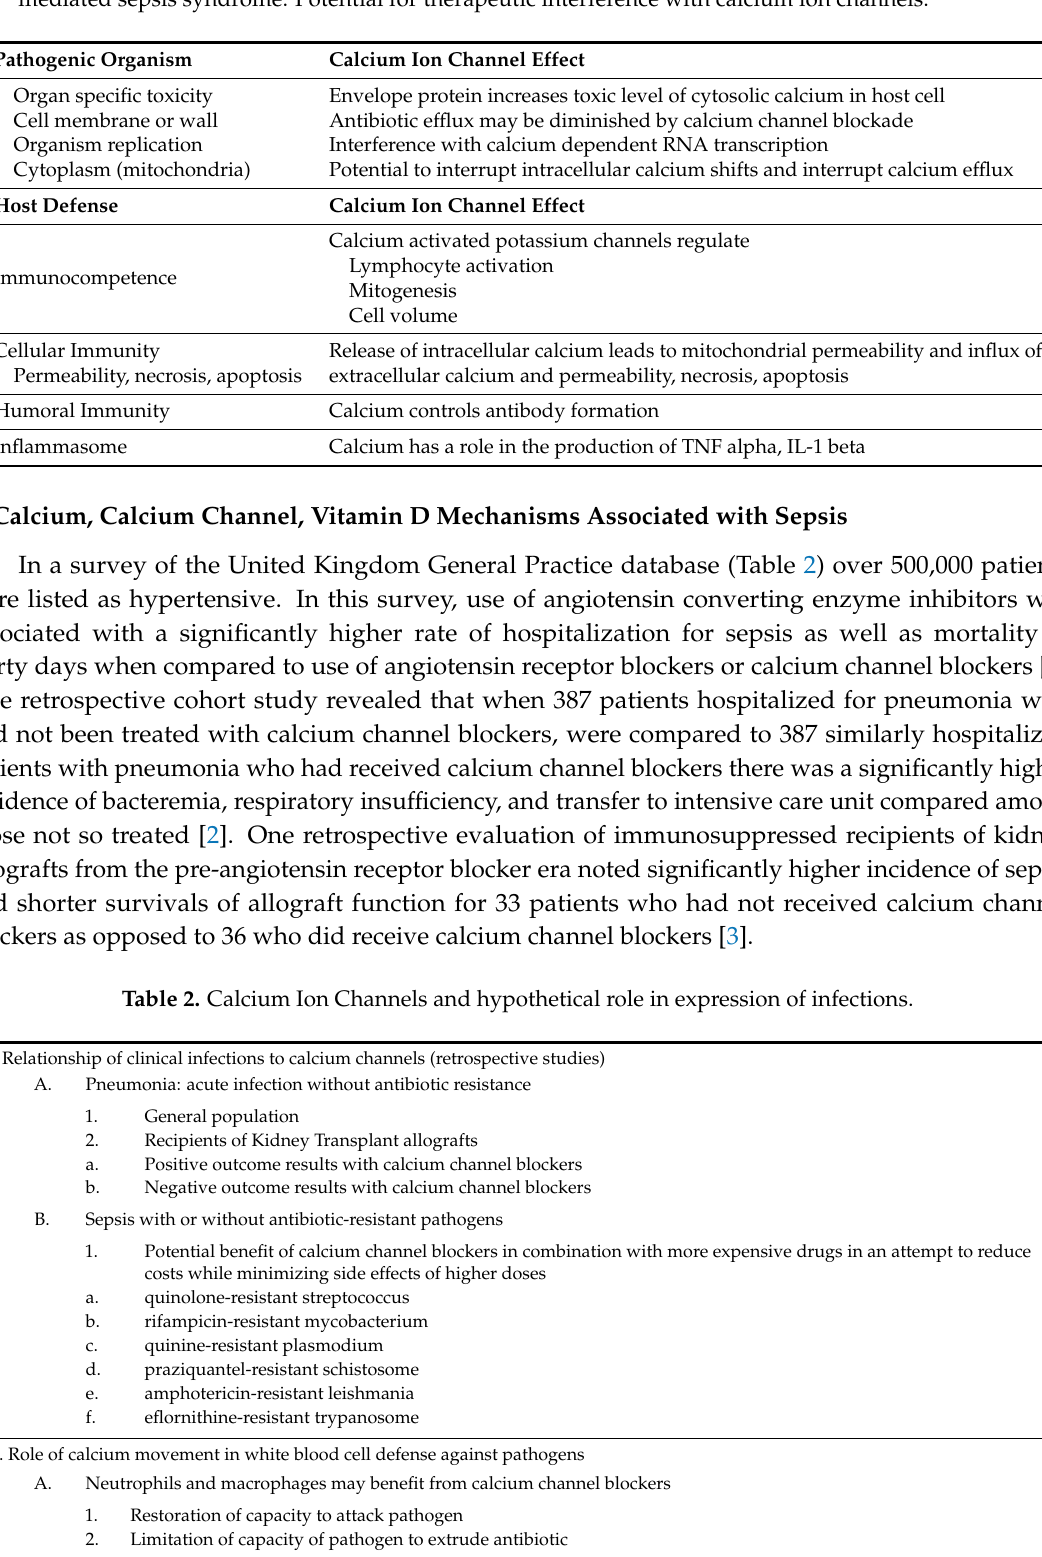
Table 1. Pathophysiologic Interactions of calcium ion channels with the production of pathogen mediated sepsis syndrome: Potential for therapeutic interference with calcium ion channels.